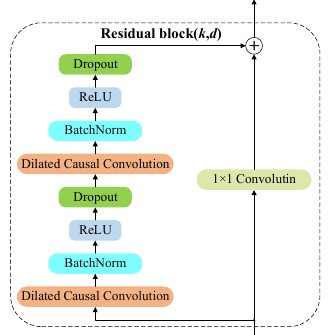
Figure 8. TCN residual block. k is the kernel size, and d is the dilation factor.